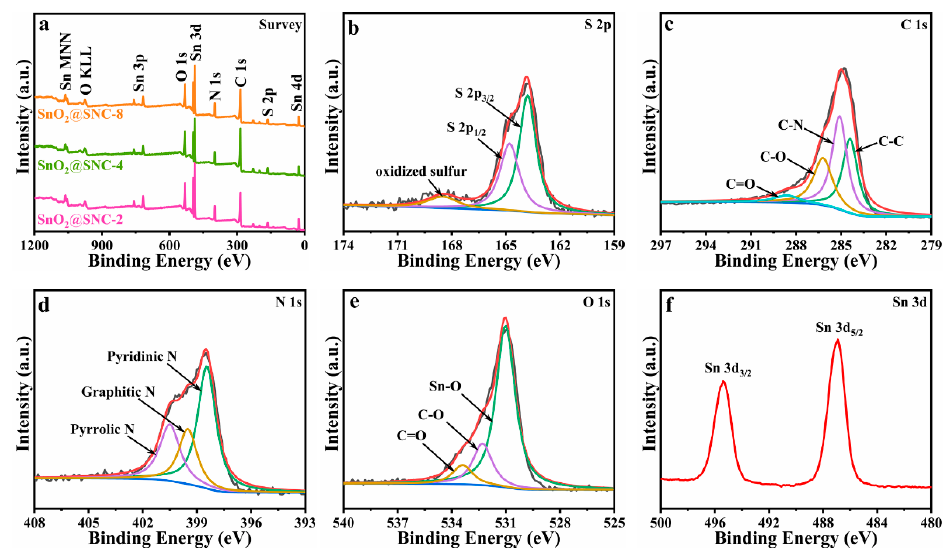
Figure 3. ( a ) XPS survey for SnO 2 @SNC − 2, SnO 2 @SNC − 4 and SnO 2 @SNC − 8 sample. ( b ) S 2p, ( c ) C 1s, ( d ) N 1s, ( e ) O 1s and ( f ) Sn 3d high resolution XPS spectrum for SnO 2 @SNC − 8 composite.